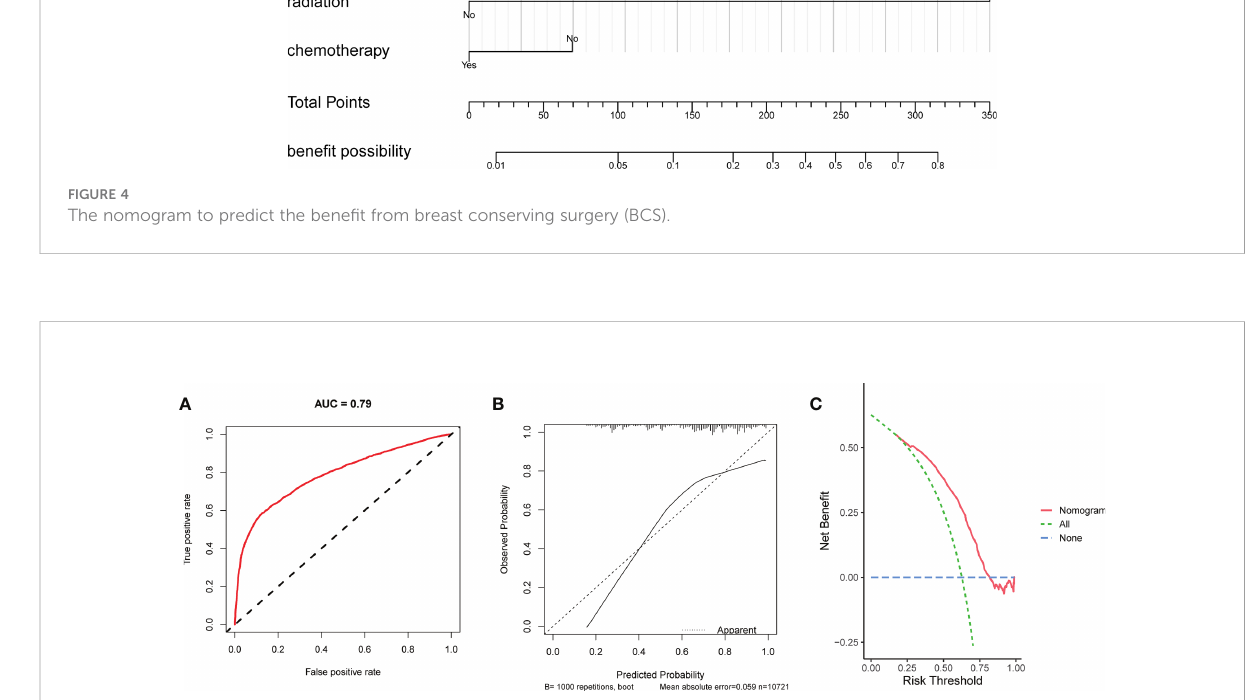
FIGURE 5 The ROC curve (A) , calibration curve (B) , and DCA curve (C) of the nomogram in the training set.